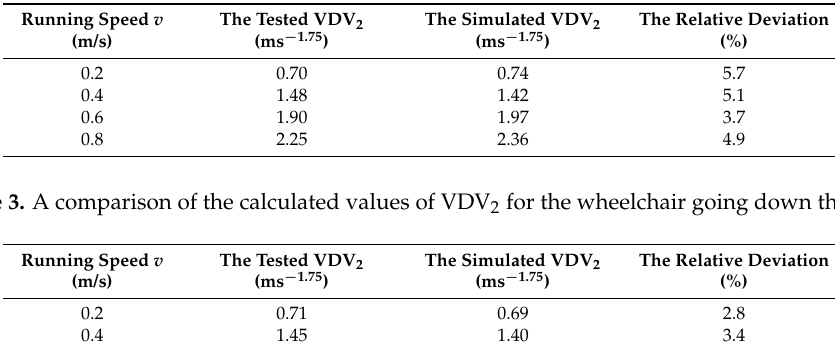
Table 2. A comparison of the calculated values of vibration dose values (VDV 2 ) for the wheelchair going up the step. Running Speed v The Tested VDV 2 The Simulated VDV 2 (m/s) (ms − 1.75 ) (ms − 1.75 )